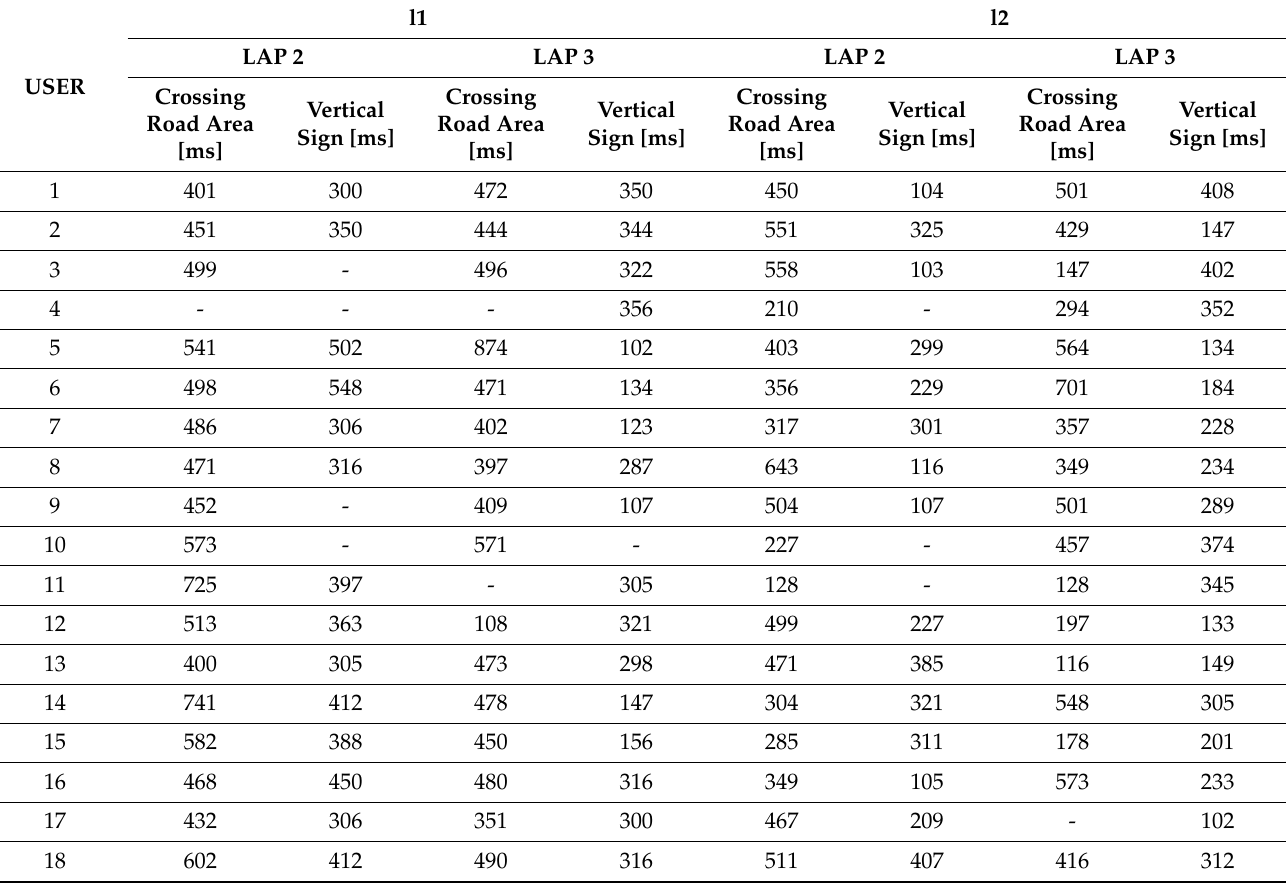
Table 1. Number of fixations for each